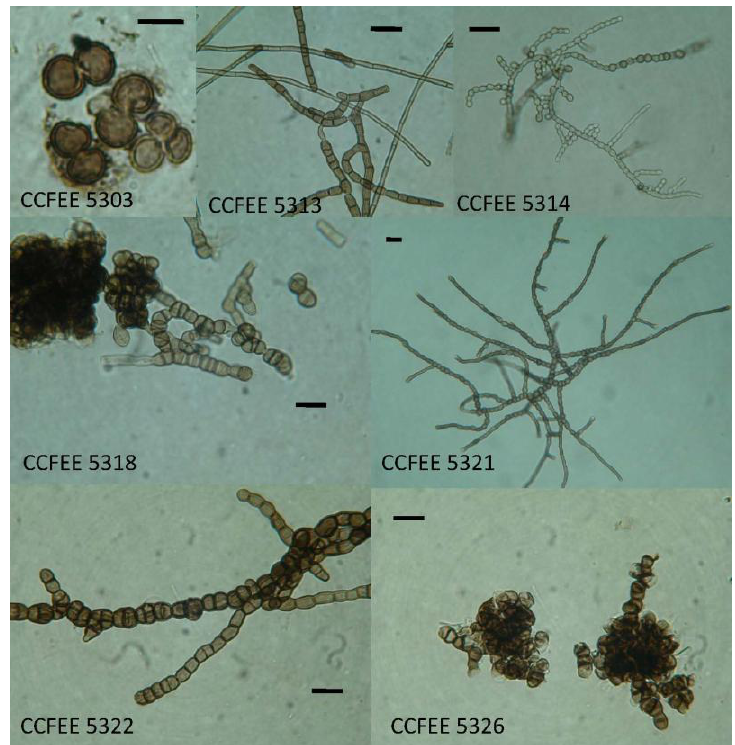
Figure 2. Some of the black fungi isolated from the lichens examined. This is a selection made based on morphological and phylogenetic